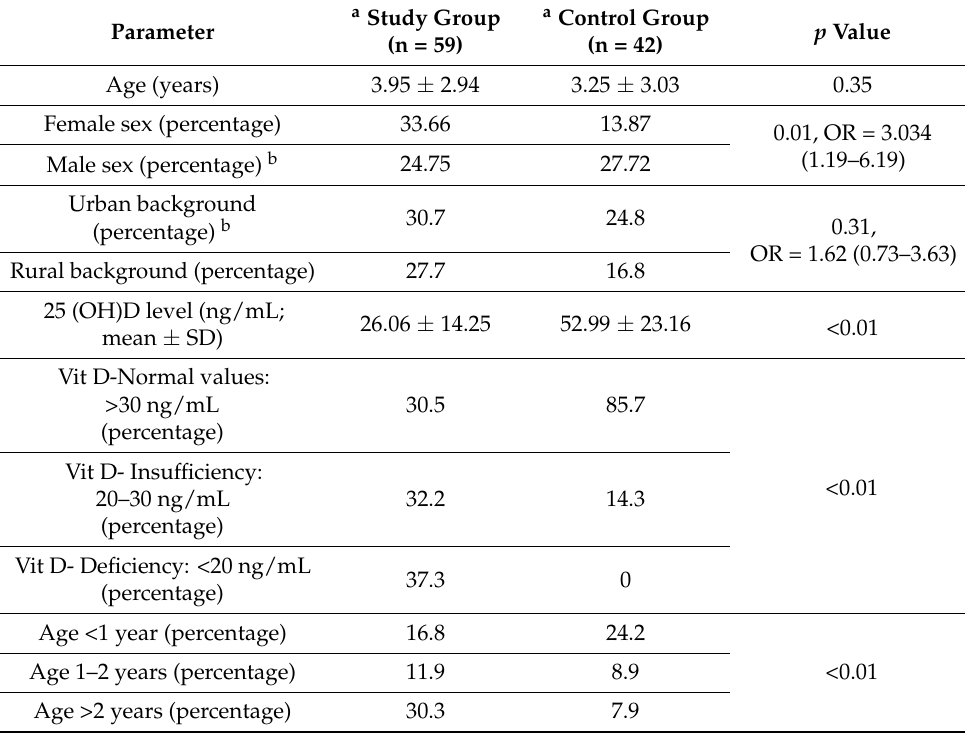
Table 1. Comparison of demographic characteristics and vitamin D levels between the study group and control